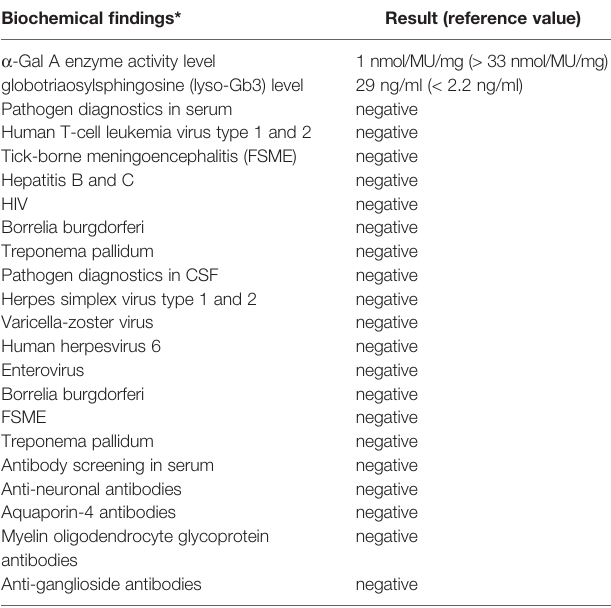
TABLE 1 | Biochemical fi ndings and laboratory data of the Fabry disease (FD) patient. Biochemical fi